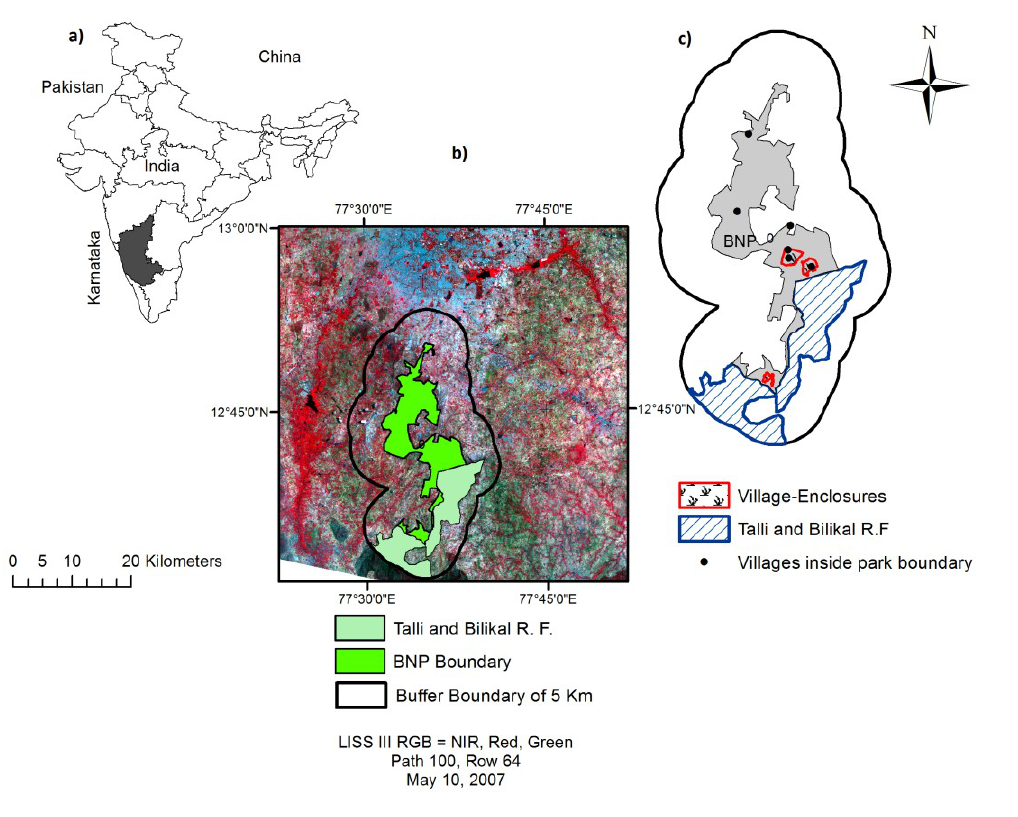
Table 1. Specifics of remotely sensed data used for the